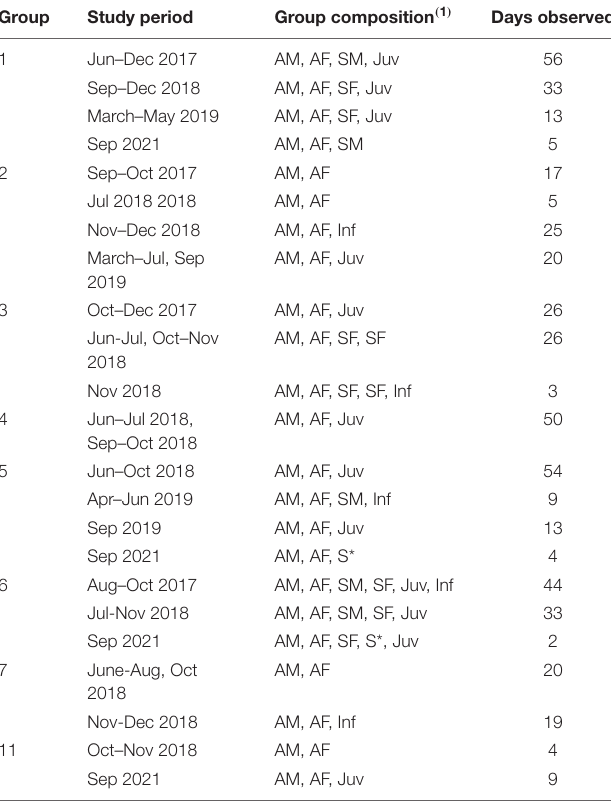
TABLE 1 | Observation periods, group compositions, and observation times for eight studied